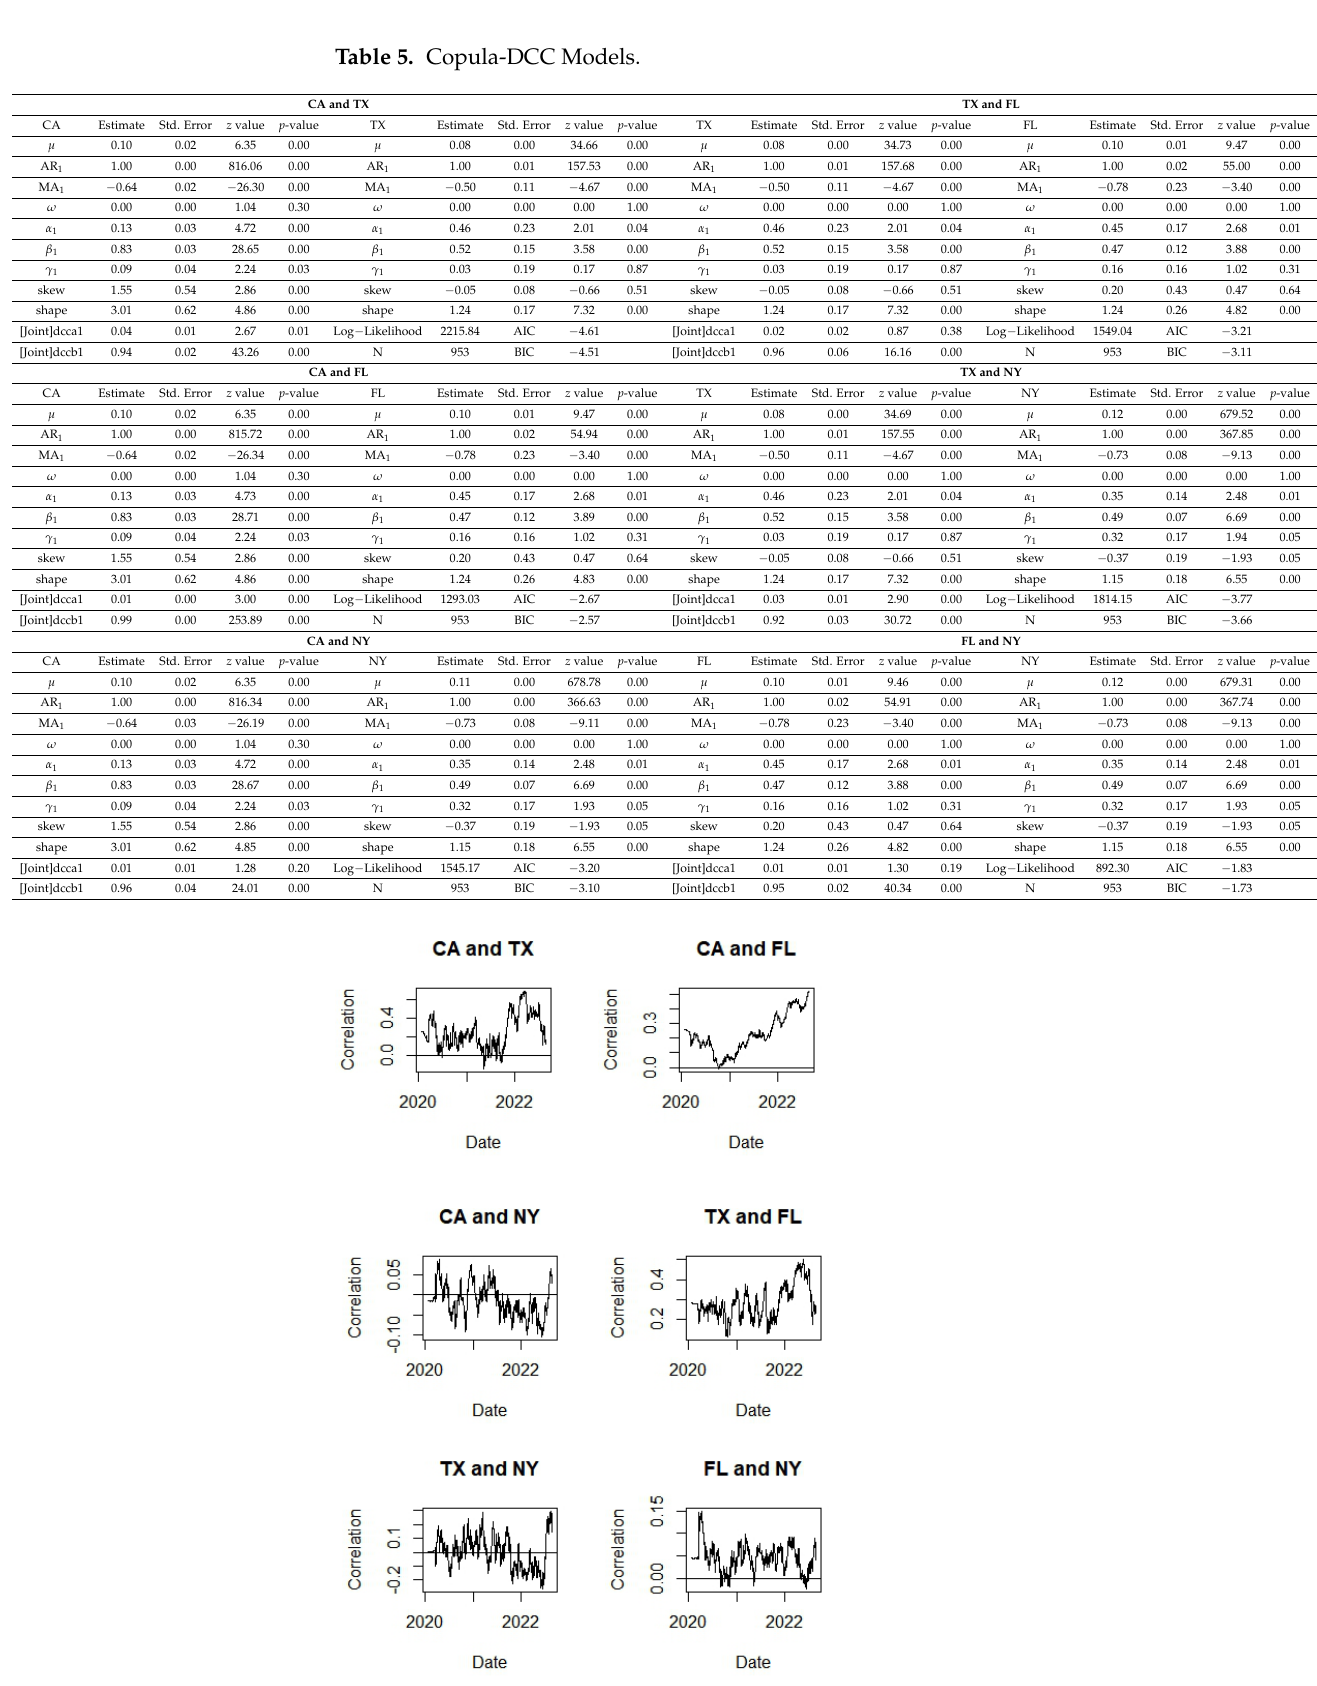
Figure 8. Plots of copula-DCC model for CA, TX, FL, and